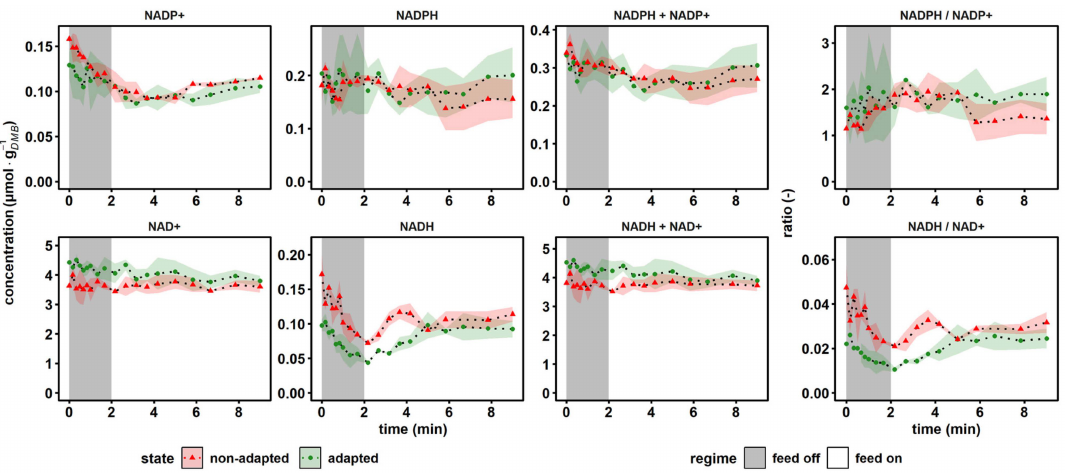
Figure 5. Dynamics of the reduction equivalents, conserved moieties and according to ratios. The non-adapted response (red) indicates dynamics following a single transition into a starvation scenario (“feed off” phase) and the adapted response (green) was sampled from representative 9 min cycles during steady-state RS. Time point 0 min of the non-adapted response was equal to steady-state RS. All values indicate means ± standard deviation of three biological replicates (except for the non-adapted time series, which was derived from two biological